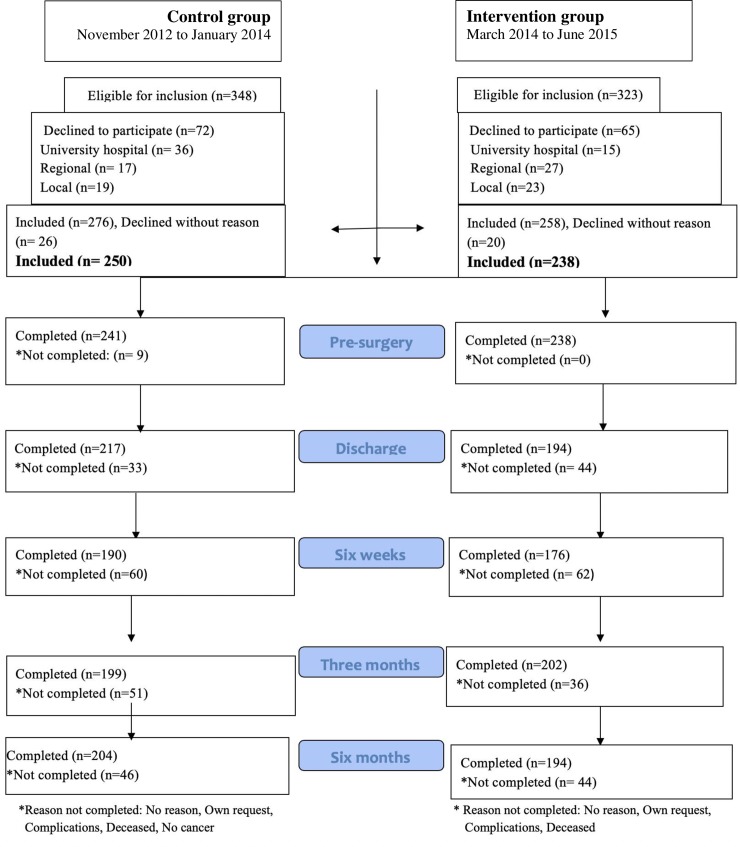
Study flow chart.